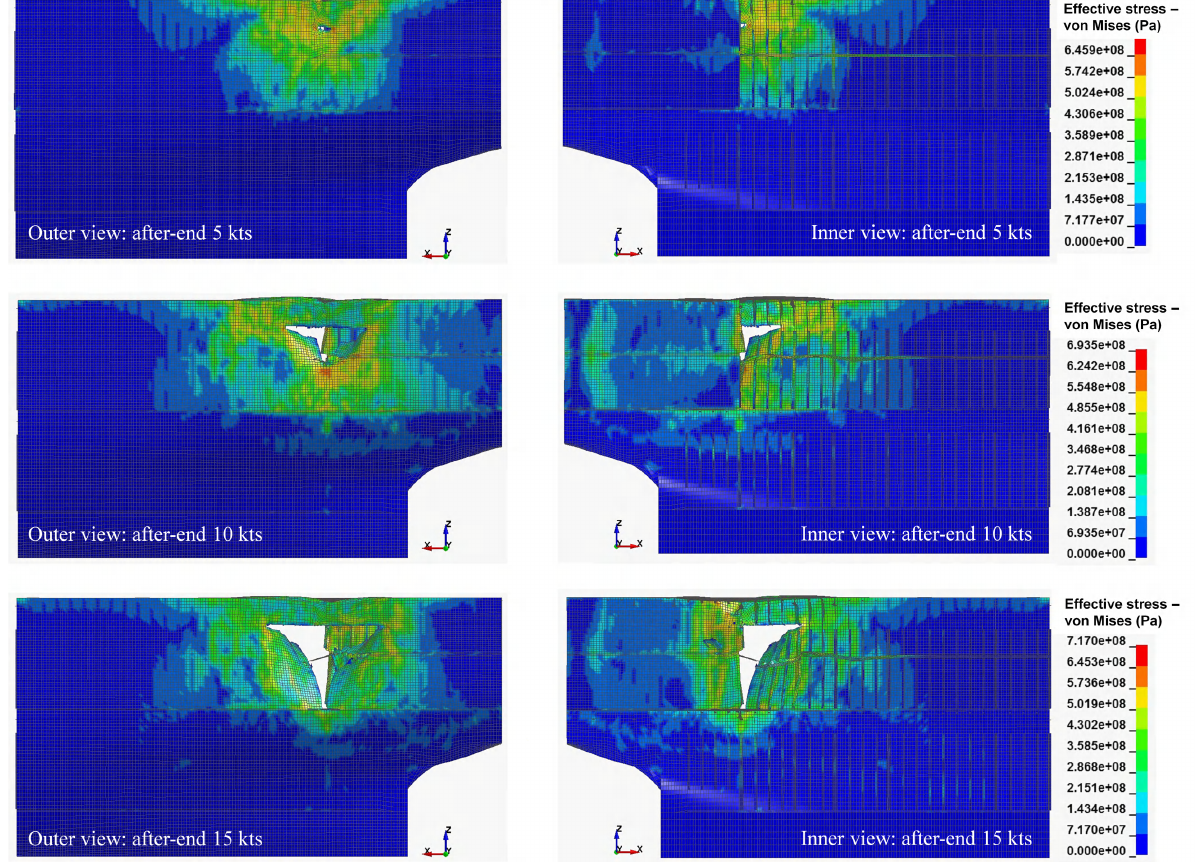
Figure 14: Damage extent and stress contours on the after-end impacted by the selected striking velocity.